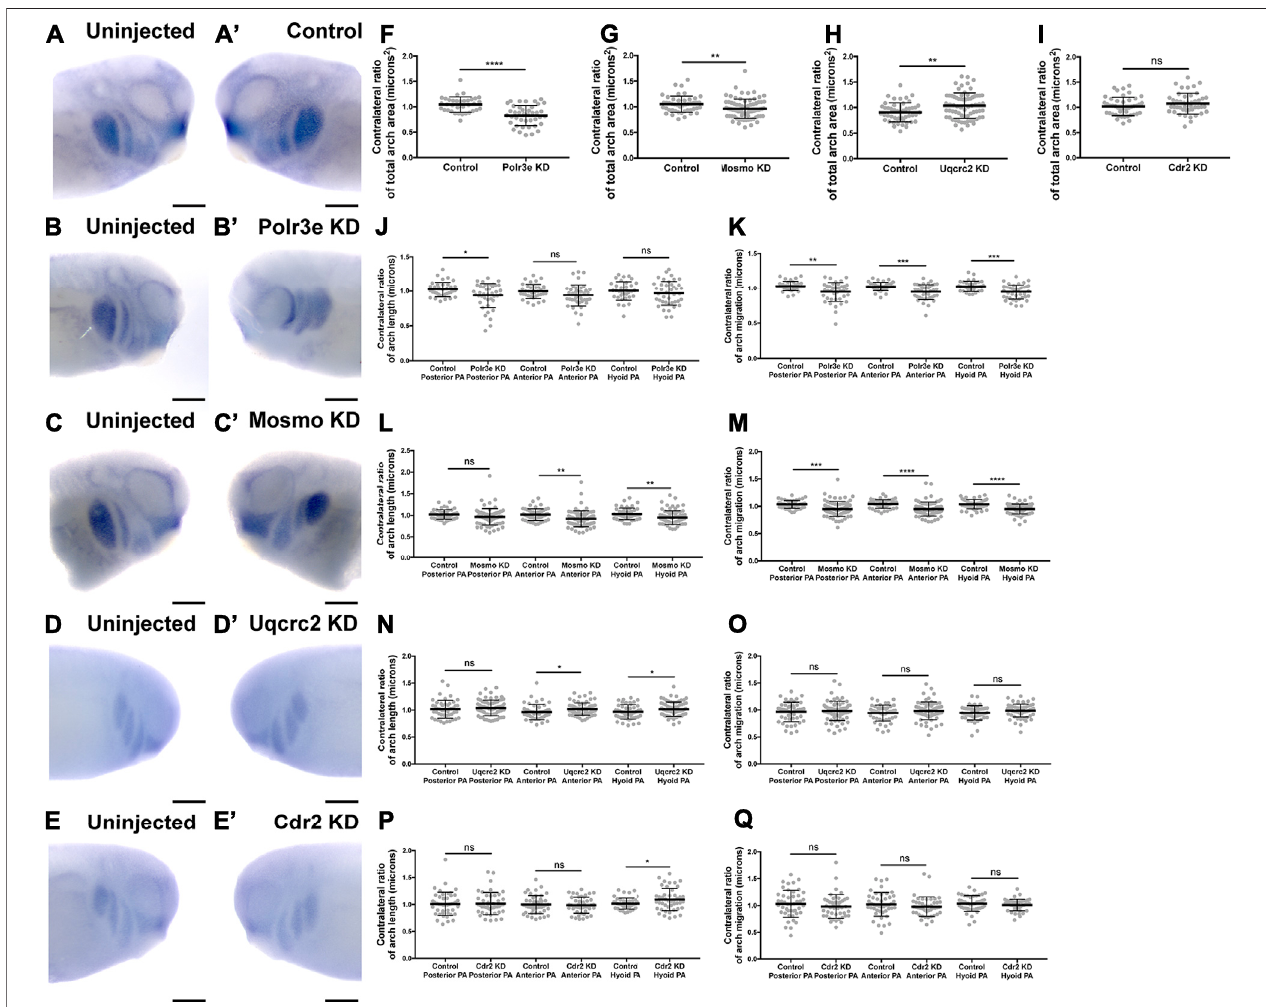
FIGURE3| KnockdownofPolr3eandMosmoaffectCNCmigration invivo . (A – C,A 9 – C)(A – E,A 9 – E 9 ) Lateralviewsofstage25embryosfollowingwhole-mount in situ hybridization against twist . Each column of panels are lateral views of two sides of the same embryo. Embryos were unilaterally injected to KD each individual 16p12.1-affected gene in half of the embryo and the other half was left uninjected. The left panels (A – E) represent the uninjected side and the right panels (A 9 – E 9 ) represent the injected side. (F – Q) Measurements were taken for the total area of the three PAs (posterior PA, anterior PA, and hyoid PA), the length of each individual arch, and the NCC migration distance, as measured from the dorsal-most tip of each arch to the neural tube, by taking ratios of the injected side versus the uninjectedside.Signi fi cancewasdeterminedusinganunpairedstudents t -testwiththeseratios. (F – H) Partialdepletionofboth Polr3eandMosmo signi fi cantlyreduced the total area of the three PAs, while partial depletion of Uqcrc2 slightly increased the total area of the three PAs. (J – K) Polr3e KD signi fi cantly reduced the length of the posteriorPAbuthadnoeffectonthelengthoftheanteriorPAorhyoidPA.However,partialdepletionofthisgenesigni fi cantlyreducedthetotalNCCmigrationdistances forallthreePAs. (L – M) MosmoKDsigni fi cantlyreducedthelengthoftheanteriorPAandhyoidPAbuthadnoeffectonthelengthoftheposteriorPA.Partialdepletionof thisgenealsosigni fi cantlyreducedthetotalNCCmigrationdistanceforallthreePAs. (N – O) Uqcrc2KDslightlyincreasedthelengthoftheanteriorandhyoidPAbuthad no effect on the length of the posterior PA, nor did it affect the total NCC migration distance. (I, P – Q) Cdr2 KD had no effect on the total area of the three PAs, nor did it affectthetotalNCCmigrationdistance.However,partialdepletionofthisgeneslightlyincreasedthelengthofthehyoidPAbutdidnotaffecttheposteriororanteriorPAs. (Embryosquanti fi ed:ControlforPolr3e=35,ControlforMosmo=48,ControlforUqcrc2=48,ControlforCdr2=45,Polr3eKD=41,MosmoKD=75,Uqcrc2KD=68, Cdr2 KD = 45). **** p < 0.0001, *** p < 0.001, ** p < 0.01, * p < 0.05, n.s., not signi fi cant. Scalebar = 300 μ m.